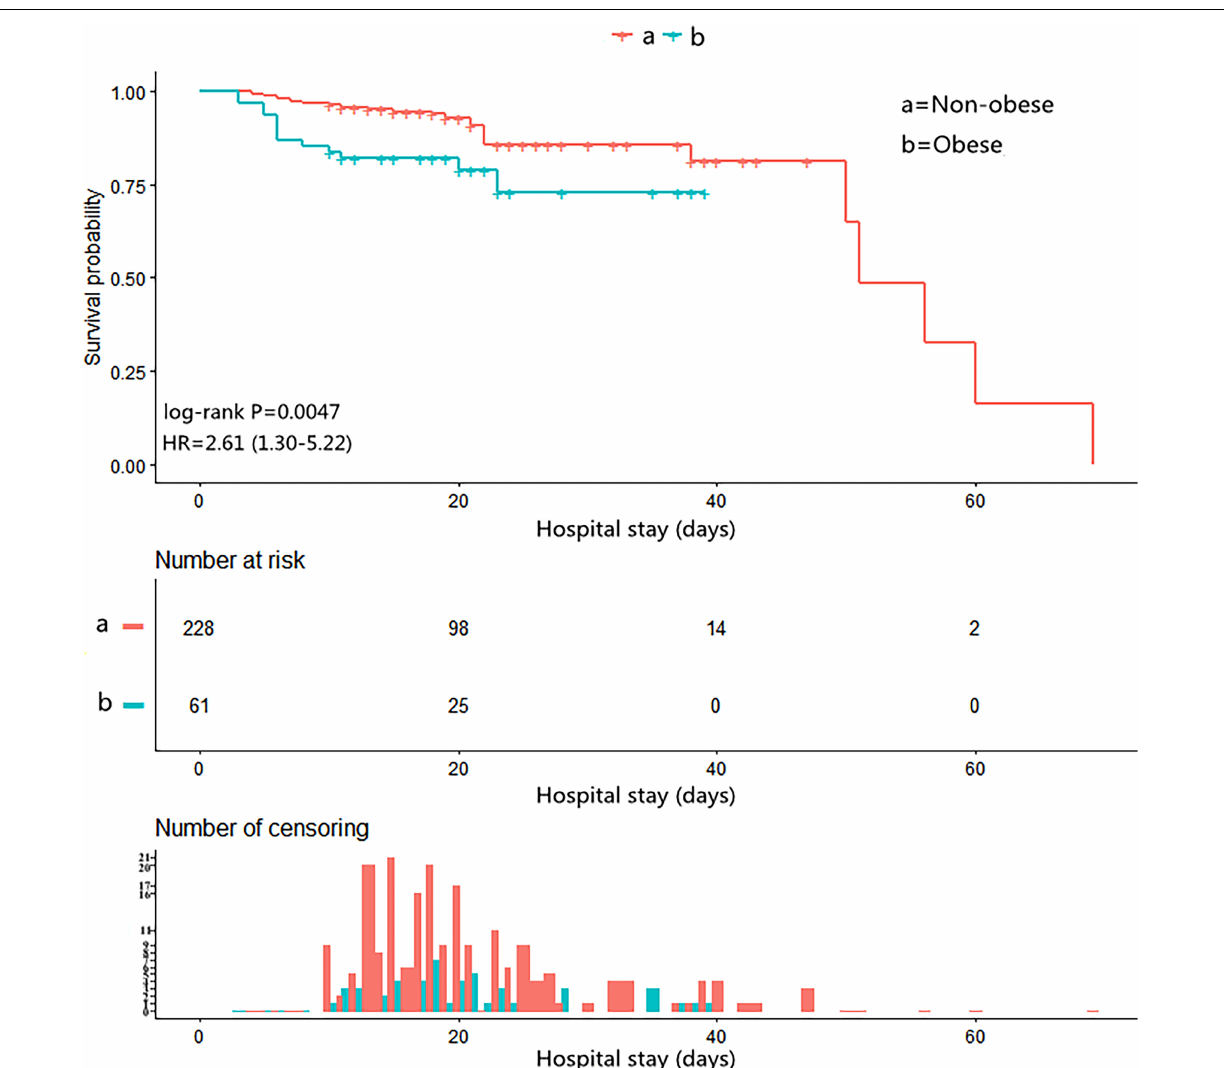
vs. 0.59, p < 0.001), and in-hospital mortality (11.4 vs. 21.31%, p = 0.043, Supplementary Figure 1